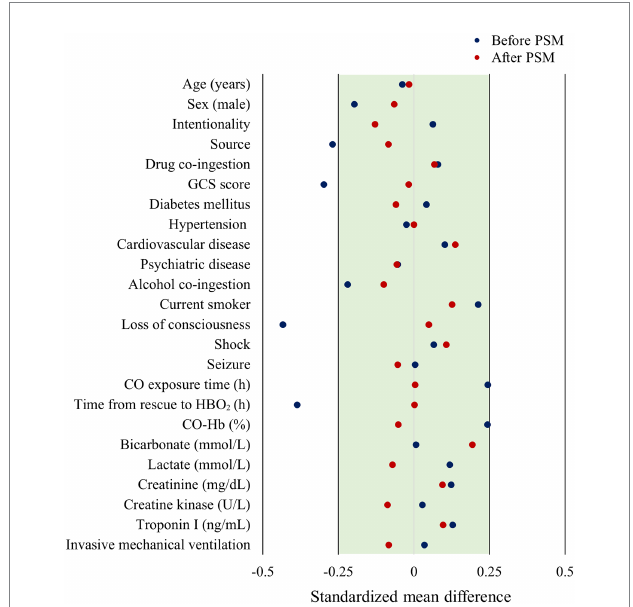
FIGURE 2 Forest plot of standardized mean difference based on before and after matching. PSM, propensity score matching; GCS, Glasgow coma scale; CO, carbon monoxide; HBO 2 , hyperbaric oxygen therapy; CO-Hb,